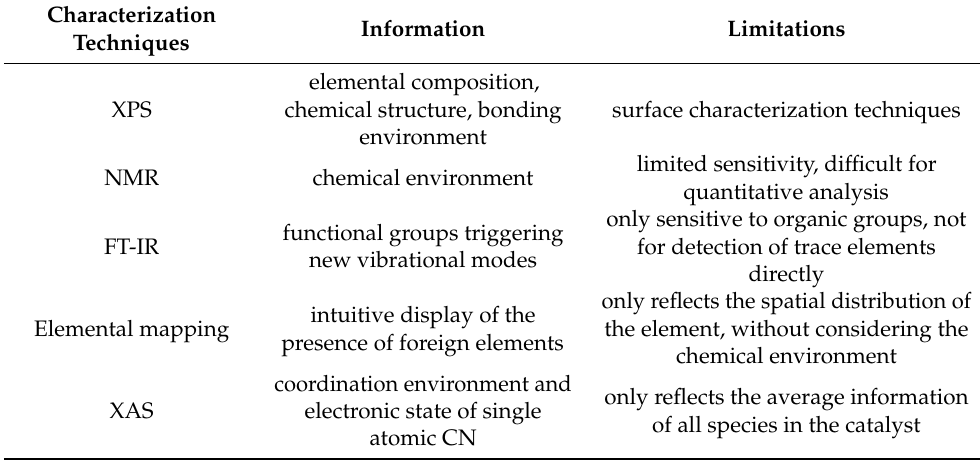
Table 2. Summary of the characterization of modified